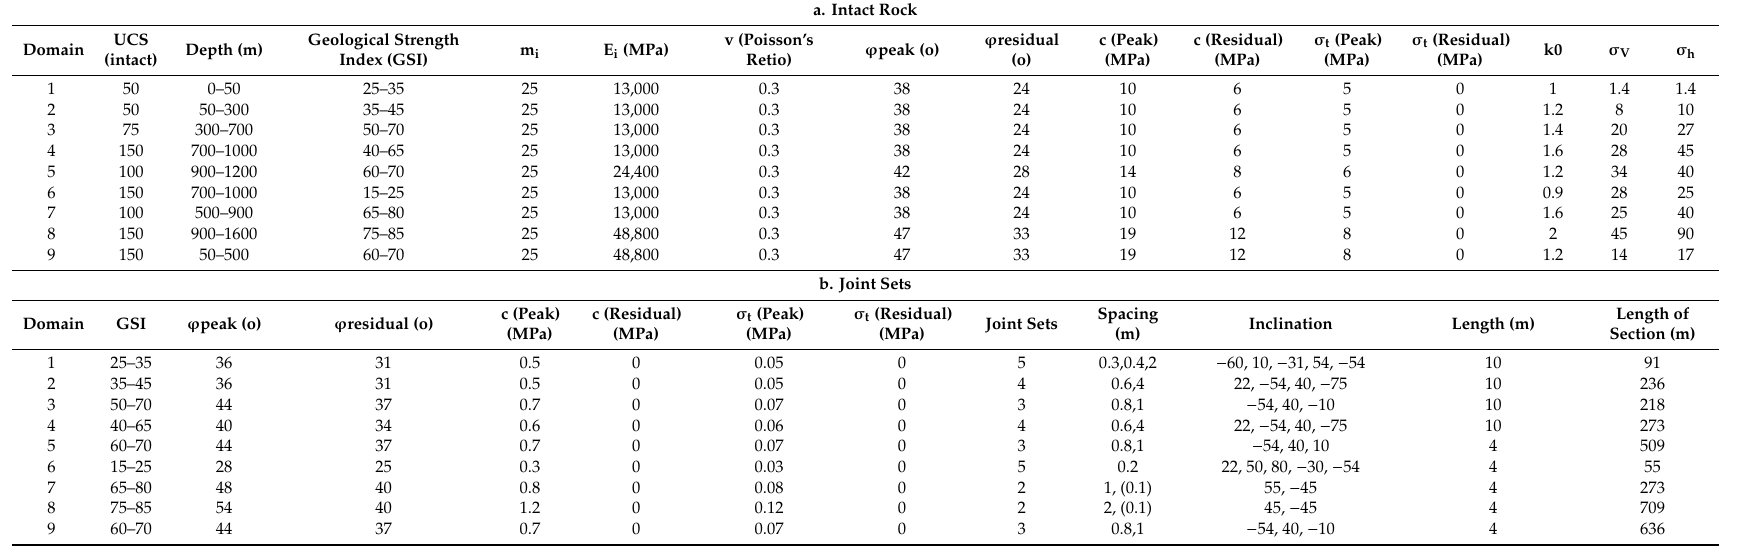
Table 9. Geotechnical parameters for: a. intact rock and b. joint